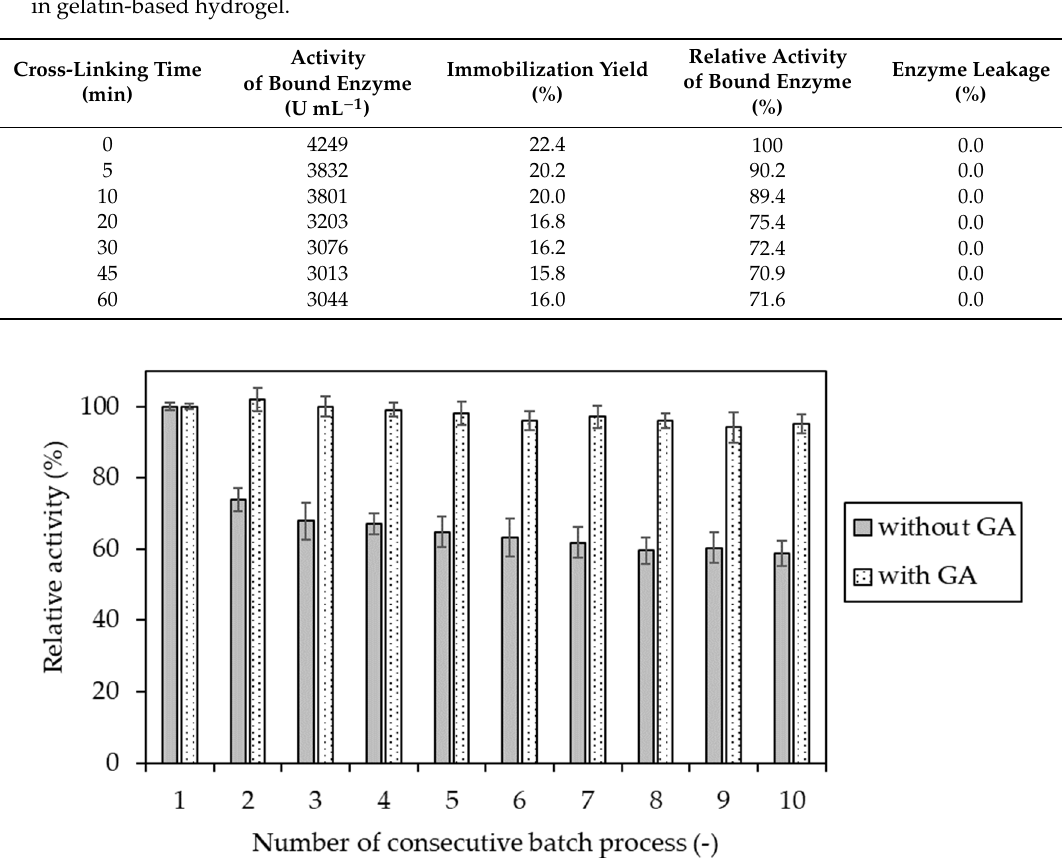
Figure 7. Relative activity of invertase immobilized in gelatin-based hydrogel determined after each of 10 consecutive batch processes. Enzyme entrapped without (gray) and with (dotted) additional step of cross-linking with glutaraldehyde. The value of activity obtained in the first reaction cycle was assumed to be 100%.